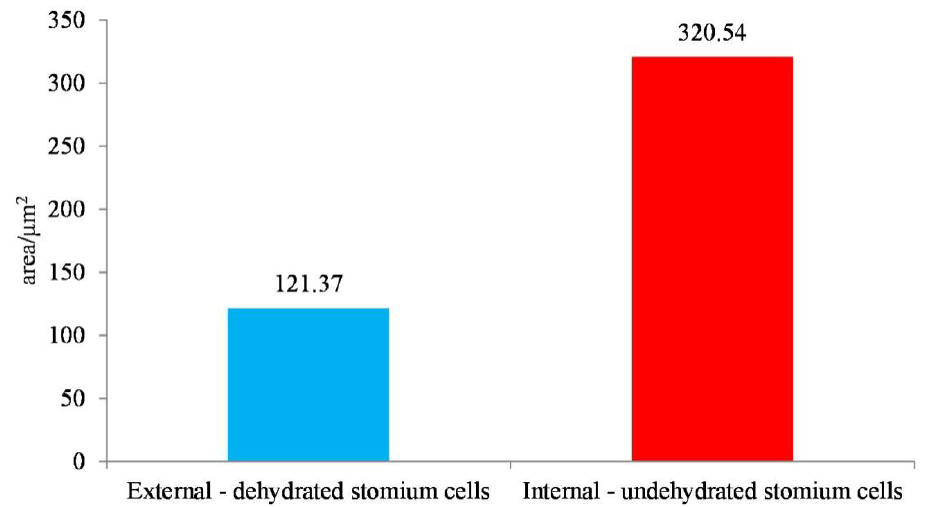
Figure 4. Change in cross-sectional area of stomium cells of Camellia oleifera during water loss.